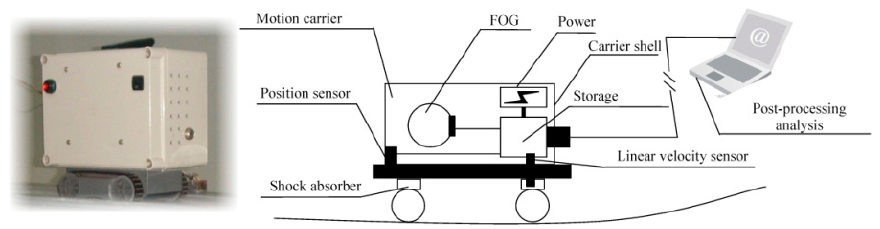
Figure 2. Measuring device integrated in a motion carrier.